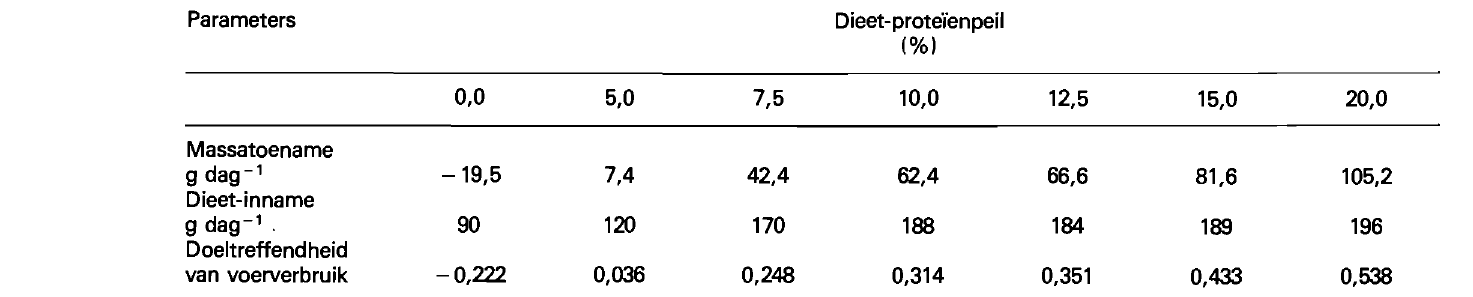
Tabel6: Die invloed van proterenpeil op die groei, dieet-inname en doeltreffendheid van voerverbruik (8 - 10 weke ouderdom)ll